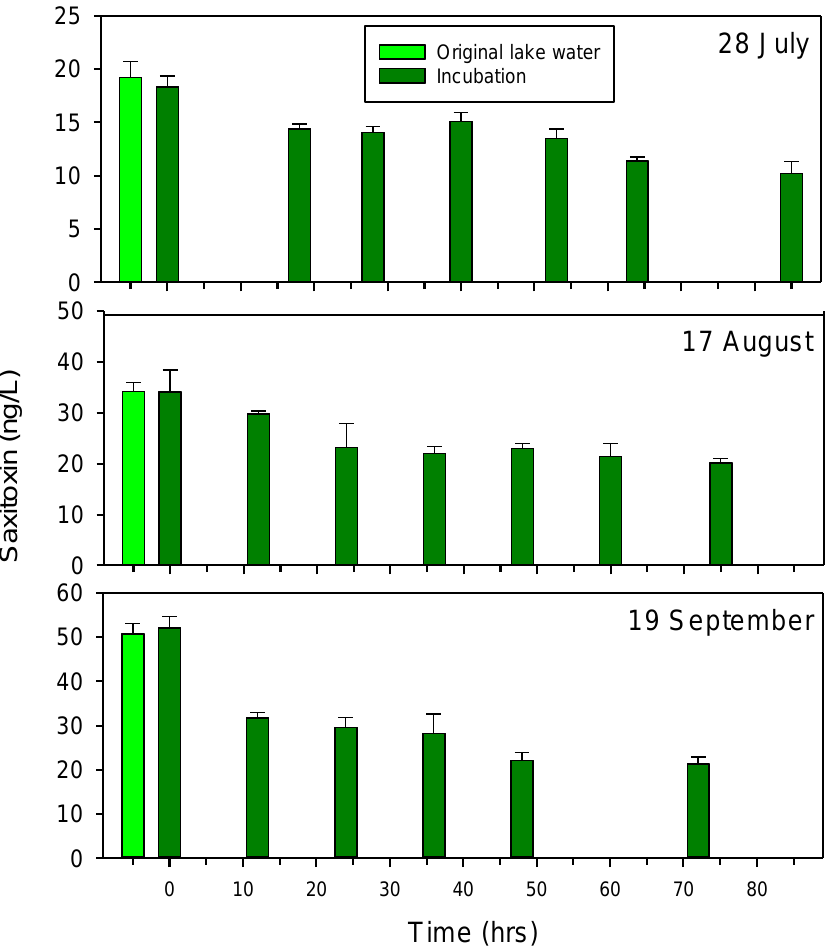
Figure 3. Microbial degradation of saxitoxin in laboratory cultures with Lake Arresø water in 2020. The cultures consisted of 90% 0.2 µ m filtered lake water mixed with 10% lake water with particles < 1.3 µ m (assumed to include bacteria only). Quantification performed by HPLC. Means ± 1 STD are shown ( n = 3).